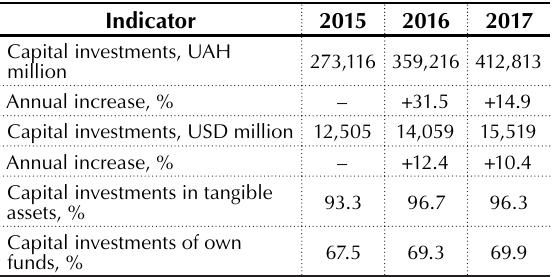
Table 1. Dynamics of capital investments into